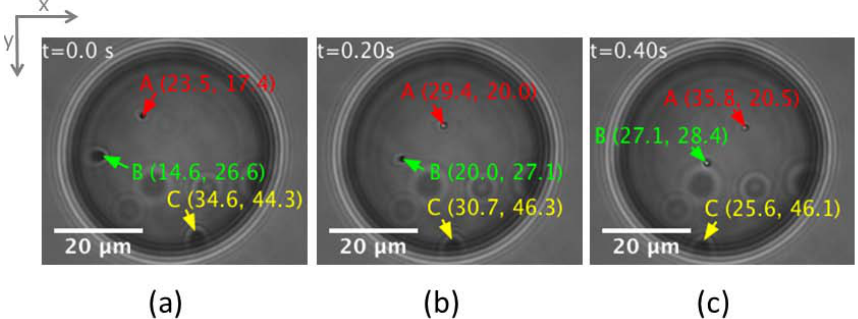
Fig. 3. Movement of beads “A” and “B” and “C” in an aqueous glycerol particle at 85% RH (a) t = 0s, (b) t = 0.20s, and (c) t = 0.40s. The x and y coordinates of the beads are included in brackets. Four other circular spots are also evident in the droplets but not labeled. These unlabeled spots are due to either beads that are stuck on the substrate surface that do not move during the experiment or due to dust on the microscope optics. Immobile beads are not included in the data collection. The gas flow is in the direction of negative x values.